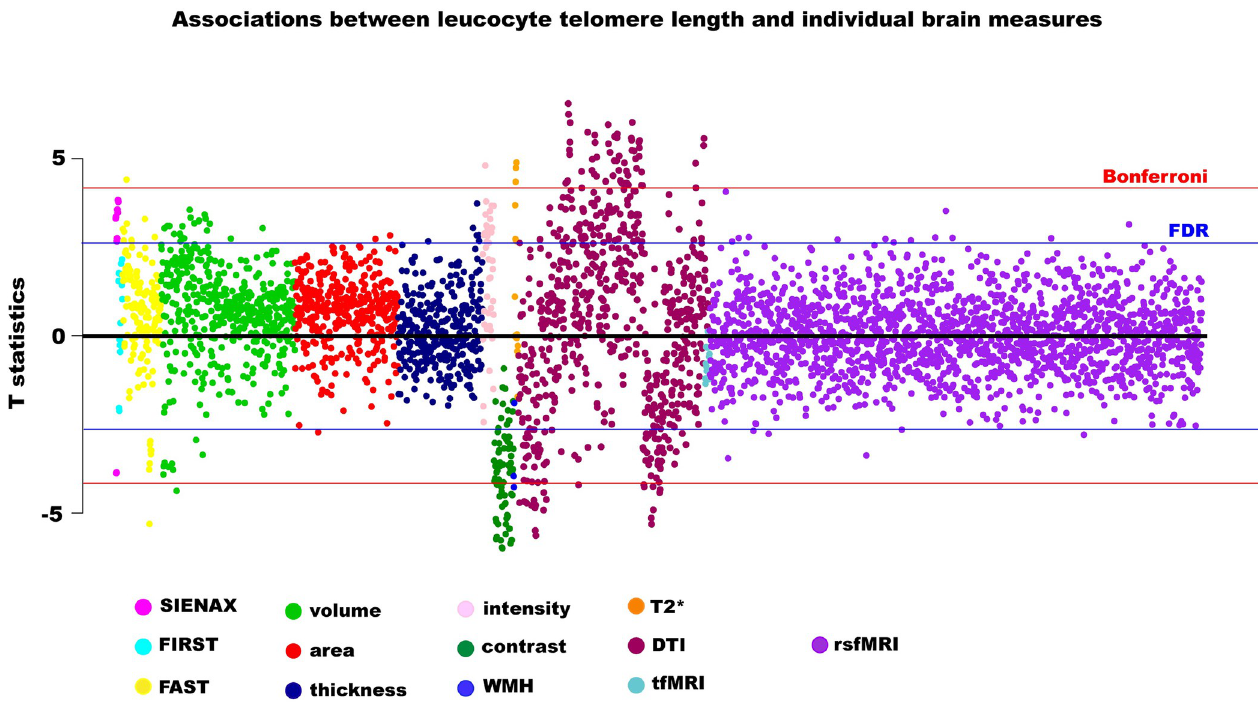
Fig 1. Associations between leucocyte telomere length and individual imaging-derived phenotypes. Estimates were generated from regression models adjusted for: full set of imaging-related confounders, age, age 2 , age 3 , sex, age � sex, body mass index, smoking, alcohol intake, leucocyte count, genetic ancestry. Blue line indicates False Discovery Rate threshold (3921 tests, p = 4.12x10 -3 , T statistic = 2.64), red line indicates Bonferroni threshold (3921 tests, p = 1.28x10 -5 , T statistic = 4.21). Abbreviations: IDP–image-derived phenotypes, dMRI–diffusion imaging, WMH–white matter hyperintensities, rsfMRI–resting state functional magnetic resonance imaging, tfMRI–task functional magnetic resonance imaging.